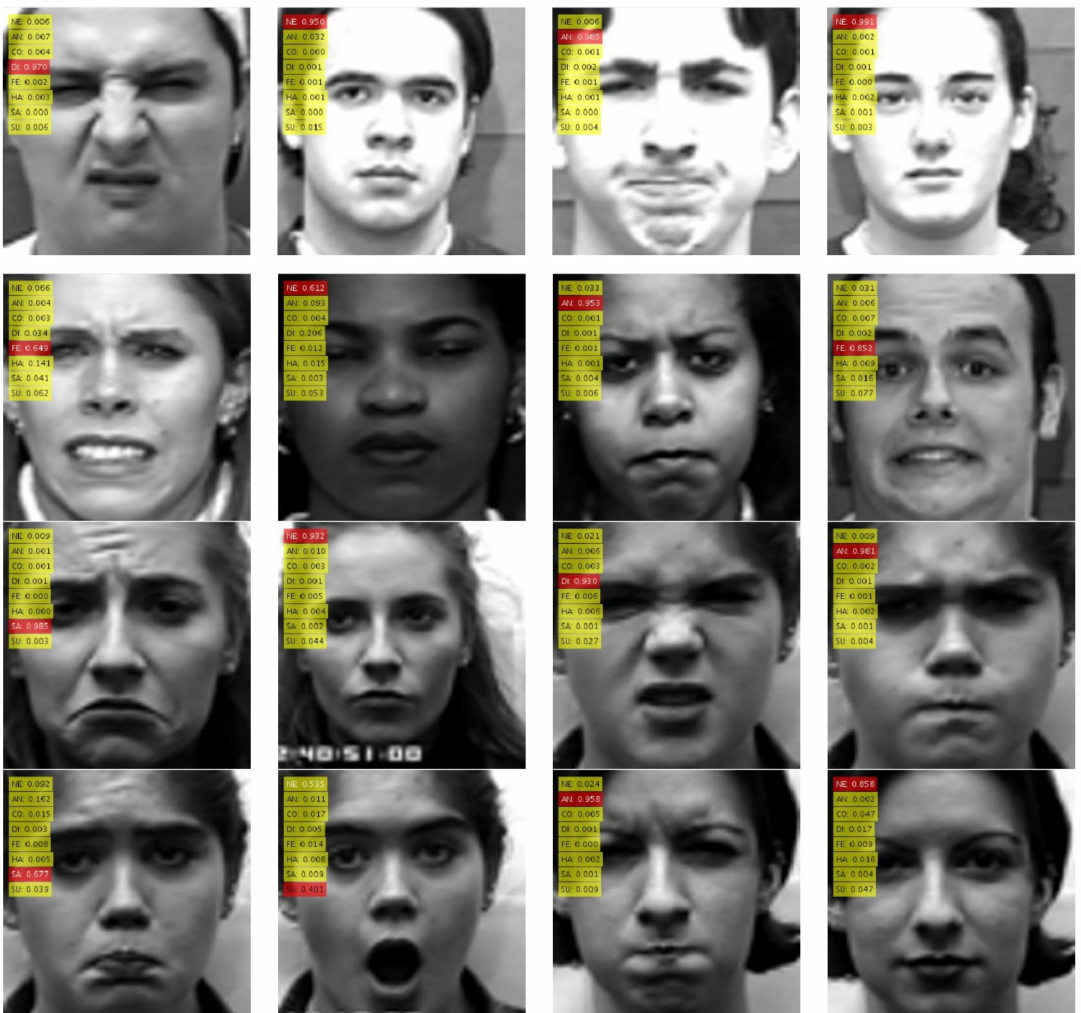
Figure 3. Classification results. The two top rows show different users, and the two bottom rows show each user with two different expressions. We denote the expression marked by the classifier system in red. Original images extracted from BU-3DFE